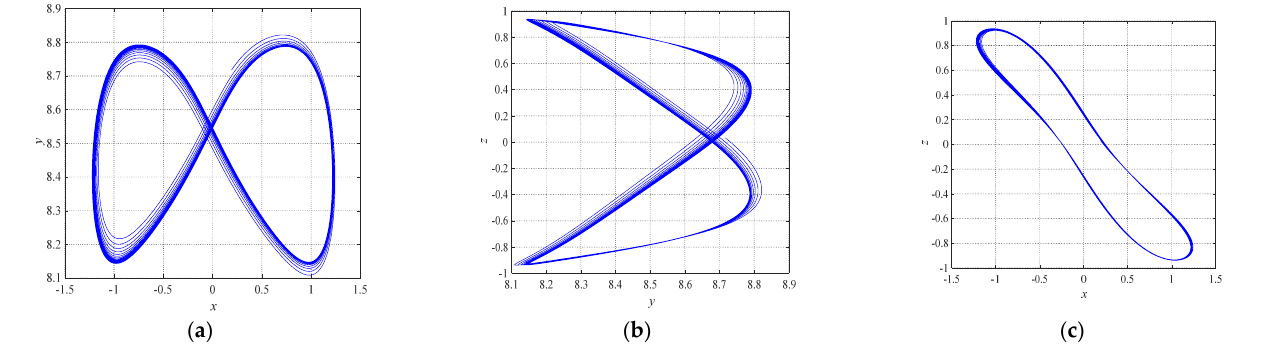
Figure 4. Phase diagrams for q = 0.90, ( a , b , c ) = ( 7.6, 0.1, 0.2 ) with x (0) = 0.4, y (0) = 0.2, z (0) = 0.5: ( a ) x-y plane, ( b ) y-z plane, and ( c ) x-z plane.